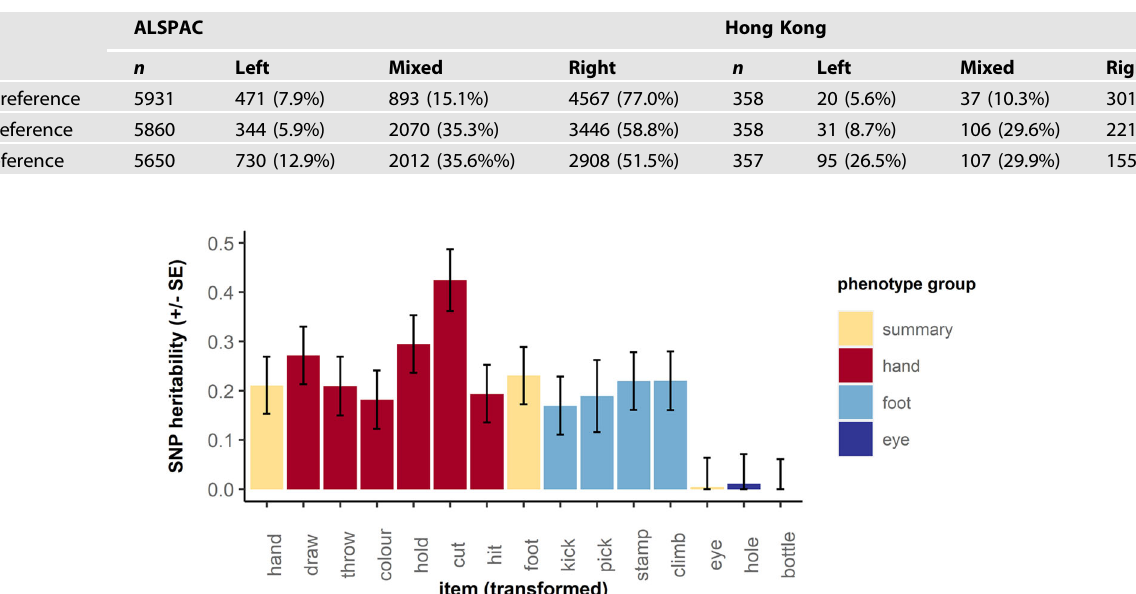
Table 1. Children with left, mixed, and right side preference for each phenotype in ALSPAC (unrelated children) and the Hong Kong cohort (twin